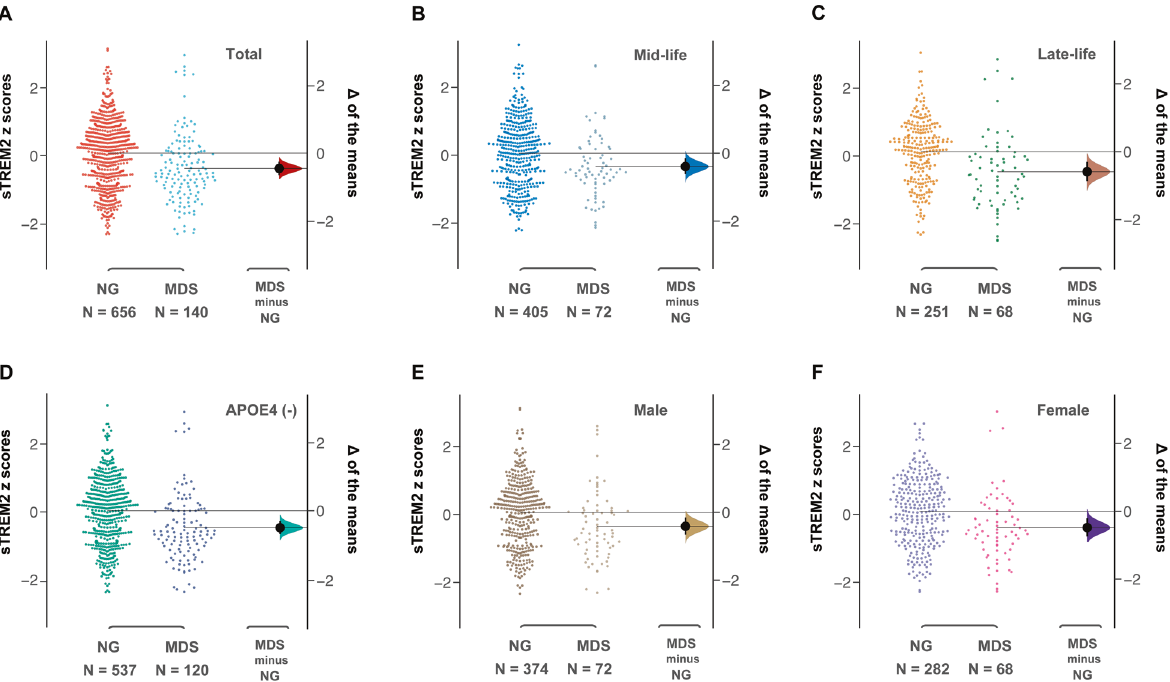
Fig. 1 Differences of CSF sTREM2 in MDSs and normal participants. Levels of CSF sTREM2 were signi fi cant lower in MDSs participants than normal participants in total ( A ), mid-life ( B ), late-life ( C ), APOE ε 4 non-carriers ( D ), male ( E ), and female ( F ). The left panel shows the distribution of raw data points for the entire dataset and the right panel shows the differences by using 5000 bootstrapped resamples and with difference- axis origin aligned to the mean of the normal group distribution. For each estimation plot: black dot represents mean difference (as indicated in right panel), black ticks indicate 95% con fi dence interval, and the shaded area represents bootstrapped sampling error distribution. CSF cerebrospinal fl uid; sTREM2 soluble of trigging receptor expressed on myeloid cells 2; MDS minimal depressive symptom; APOE apolipoprotein E.